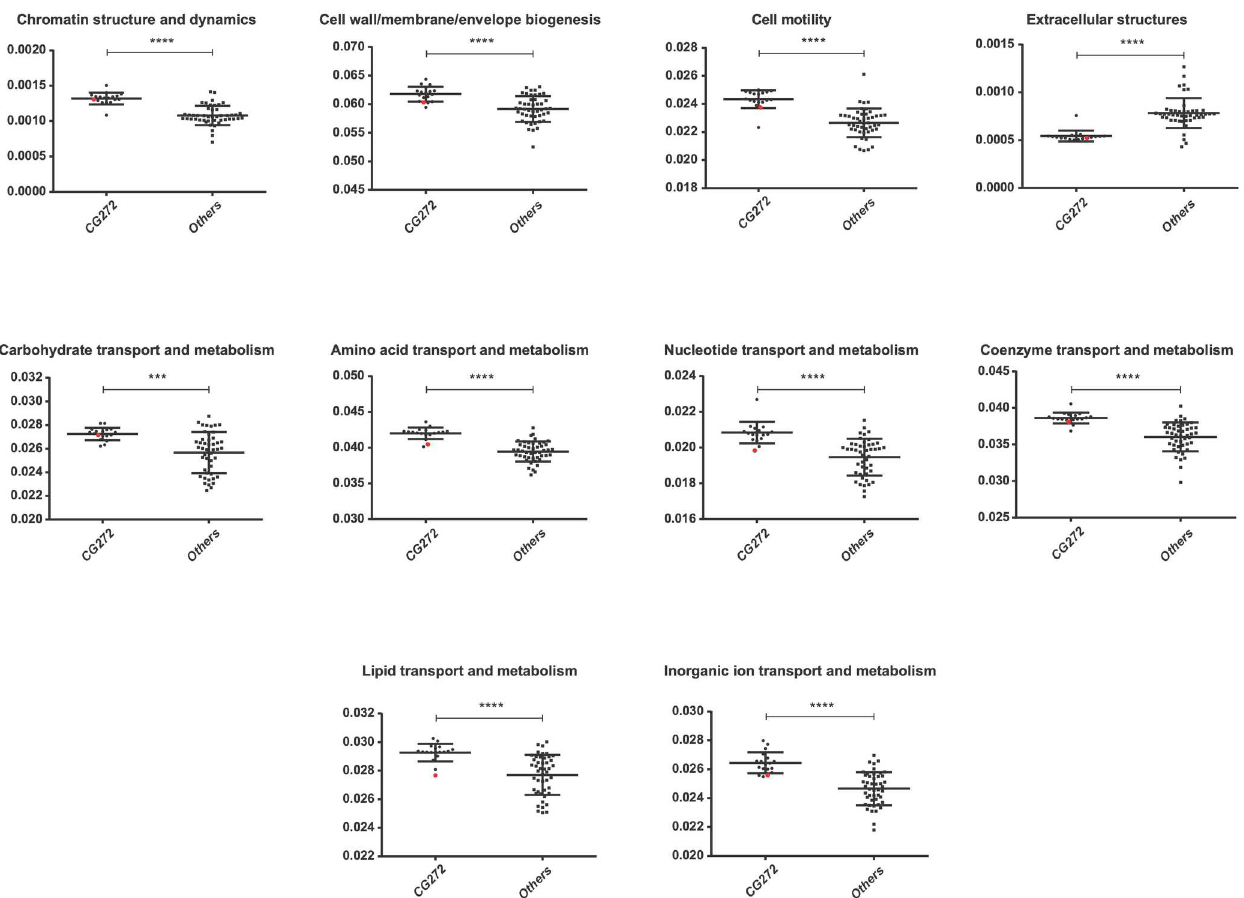
Fig 4. Distribution in functional categories of the predicted CDSs (%). Each dot represents the value for a specific genome after normalizing by its predicted total number of proteins. The genome-specific values of the L . interrogans CG272 strains and L . interrogans non- CG272 strains are presented. The genome of L . interrogans sg Autumnalis strain id779 is represented as a red dot. Only functional categories showing significant difference between the different groups are shown ( ��� P < 0.001, ���� P < 0.0001).